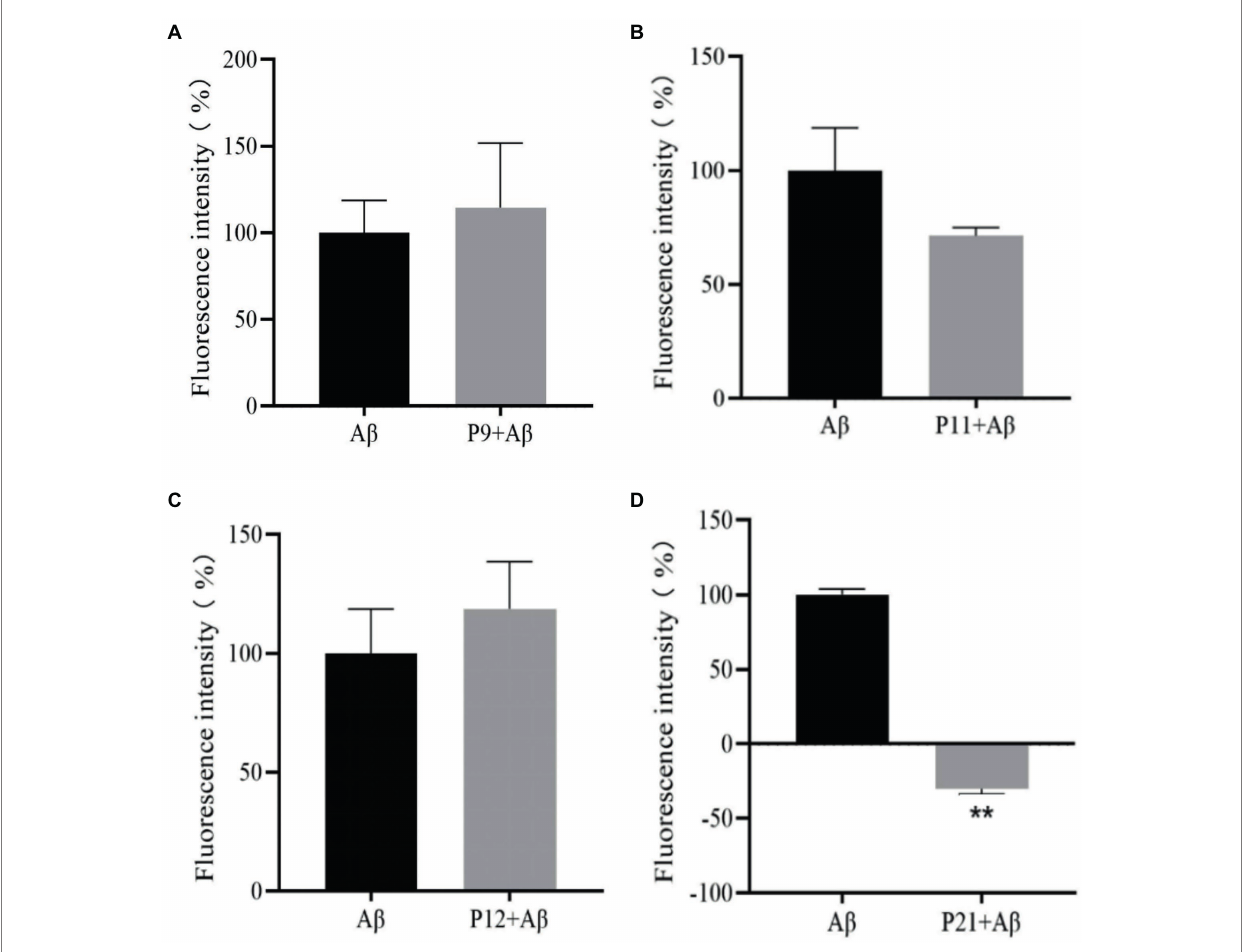
FIGURE 4 The result graph of the aggregation fluorescence intensity of peptides P9, P11, P12, P21 on A β 1–42 . (A) P9 (B) P11 (C) P12 (D)